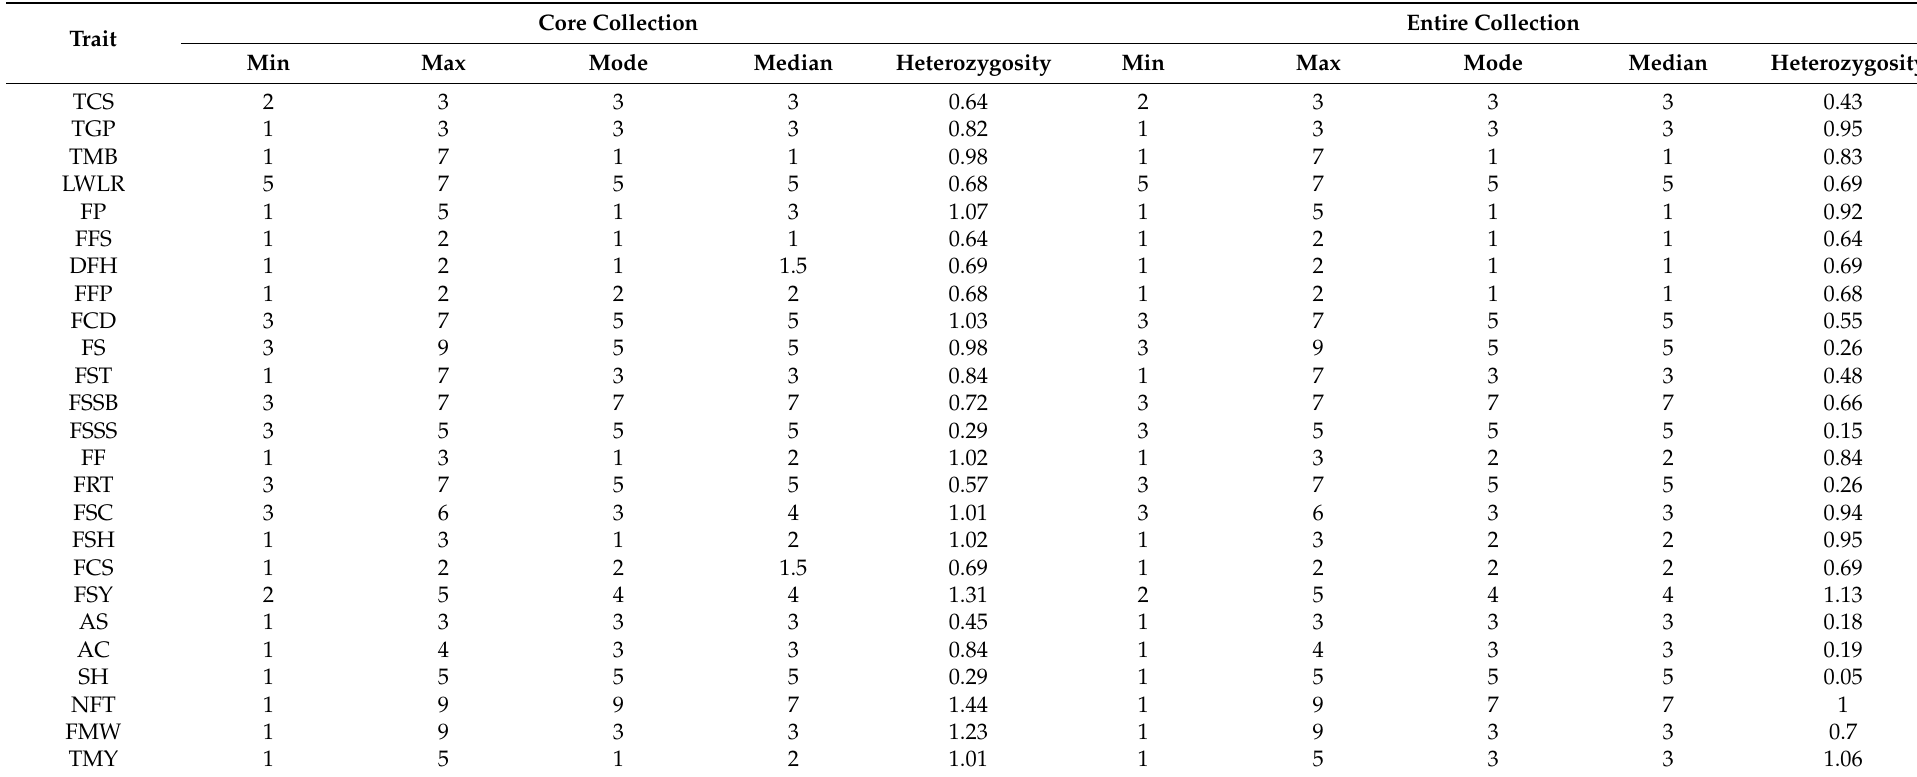
Table 1. Descriptive statistics of the phenotypic traits in both entire and core collections of 221 pomegranate genotypes. Tree Crown Shape ( TCS ); Tree Growth Power ( TGP ); Thorn in Mature Wood Branch ( TMB ); Length − to − width Leaf Ratio ( LWLR ); Flower Position ( FP ); Flower Formation Site ( FFS ); Dominant Flowering Habit ( DFH ); Fruitful Flowers Percentage ( FFP ); Flower Cup Diameter ( FCD ); Fruit Size ( FS ); Fruit Skin thickness ( FST ); Fruity Skin Sensitivity to Burst ( FSSB ); Fruit Skin Sensitivity to Sunburn ( FSSS ); Fruit Flavor ( FF ); Fruit Ripening Time ( FRT ); Fruit Skin Color ( FSC ); Fruit Shape ( FSH ); Fruit Crown Shape ( FCS ); Fruit symmetry ( FSY ); Aril Size ( AS ); Seed Color ( SC ); Seed Hardness ( SH ); Number of fruits in tree ( NFT ); Fruit mean weight ( FMW ); Tree mean yield ( TMY